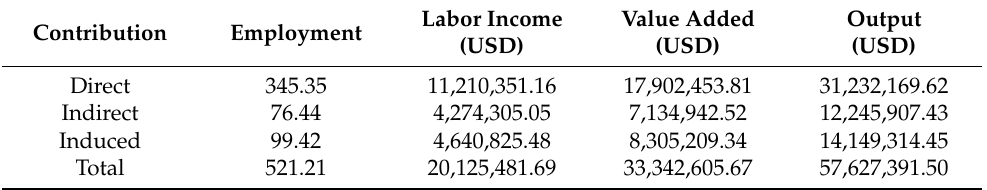
Table A1. Total Annual Economic Contribution of GTM to Duval, Flagler, and St. Johns Counties. Contribution